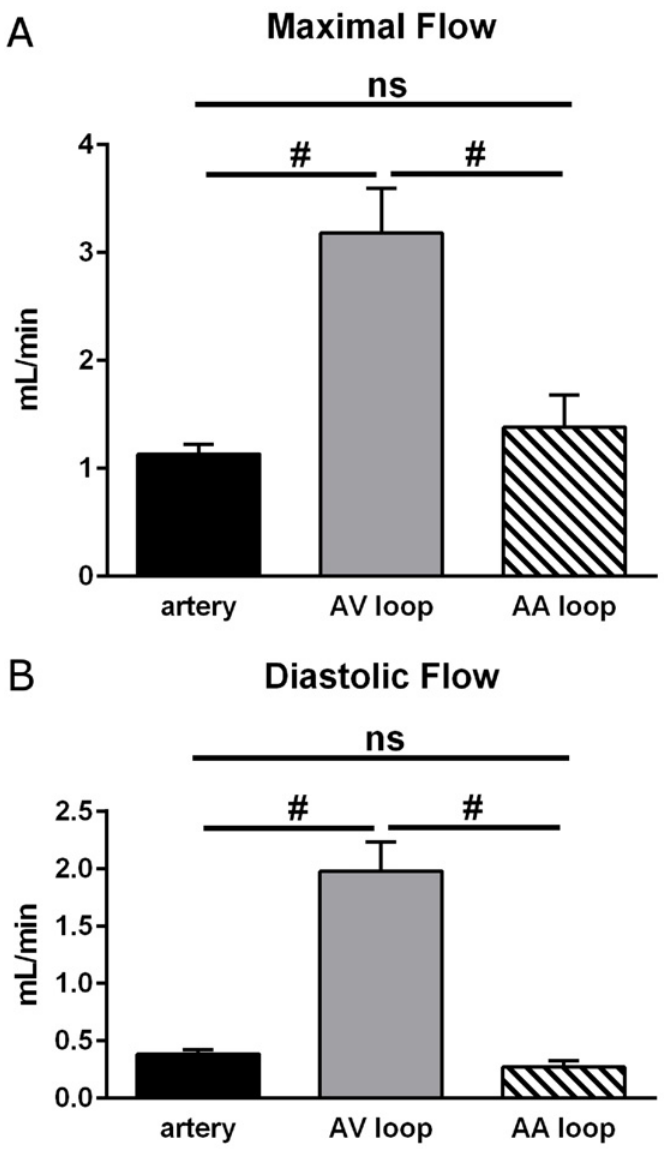
distinct flow increase indicating the next systole. Flow in AV loops was strongly enhanced at both times indicating that flow increased throughout the cardiac cycle. In contrast, neither maximal nor diastolic flow was enhanced in AA loops compared to arteries. Considering the similar diameter of veins transplanted either as AV or AA graft (for values see text, basic data) wall shear rate is accordingly elevated in AV loops